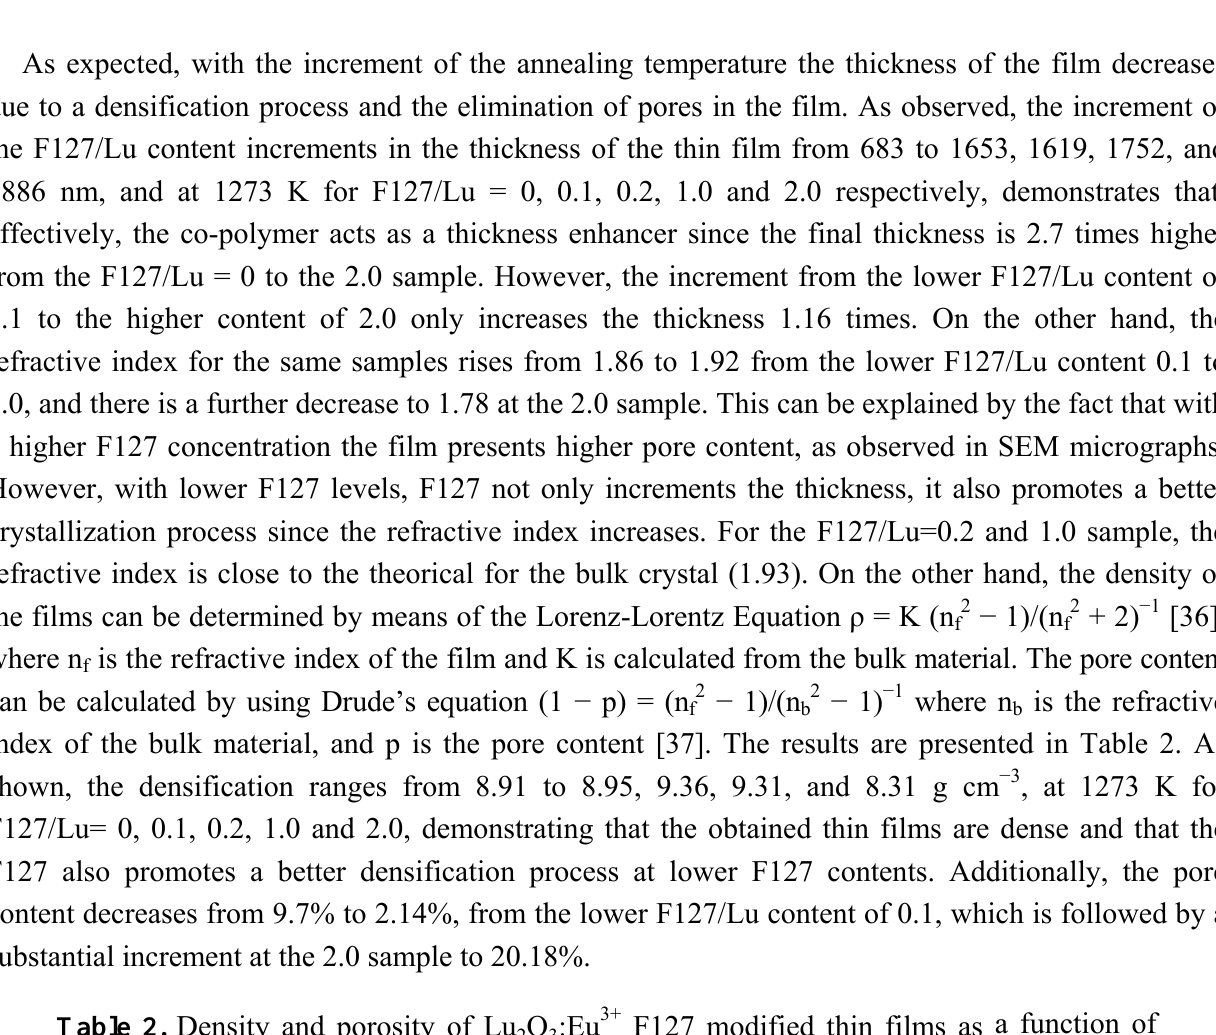
O :Eu 3+ F127 modified thin films as a function of 2 3